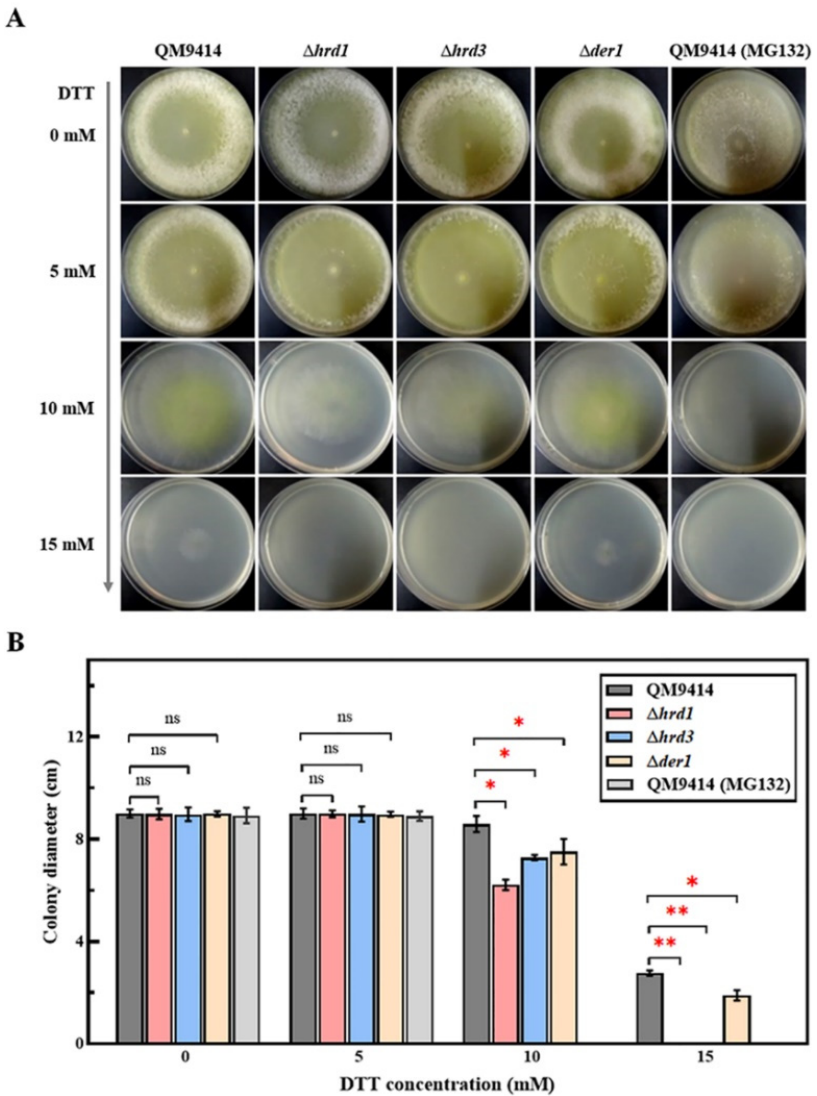
Figure 1. Colony morphology and growth of the ERAD-deficient mutants under different concen- trations of the stress agent DTT. ( A ) Plate photographs show the morphology of the control strains and the genetically manipulated ERAD-deficient mutants with increasing concentrations of DTT. The DTT concentrations added to the medium were 0, 5, 10 and 15 mM, respectively. The parental strain QM9414 treated with the proteasome inhibitor MG132 was used as the control. The strains were grown on MM containing glucose as the carbon source at 30 ◦ C for 3 days. ( B ) Colony diameter of QM9414 (treated without/with MG132) and the ERAD-deficient mutants with increasing concentra- tions of DTT. Values represent the mean of three repeated measurements taken from at least three parallel experiments. The error bars refer to the standard deviations. The difference between the parental strain and the knockout strains was shown by analysis of ANOVA followed by Tukey’s test. * p < 0.05; ** p < 0.01. ns, not